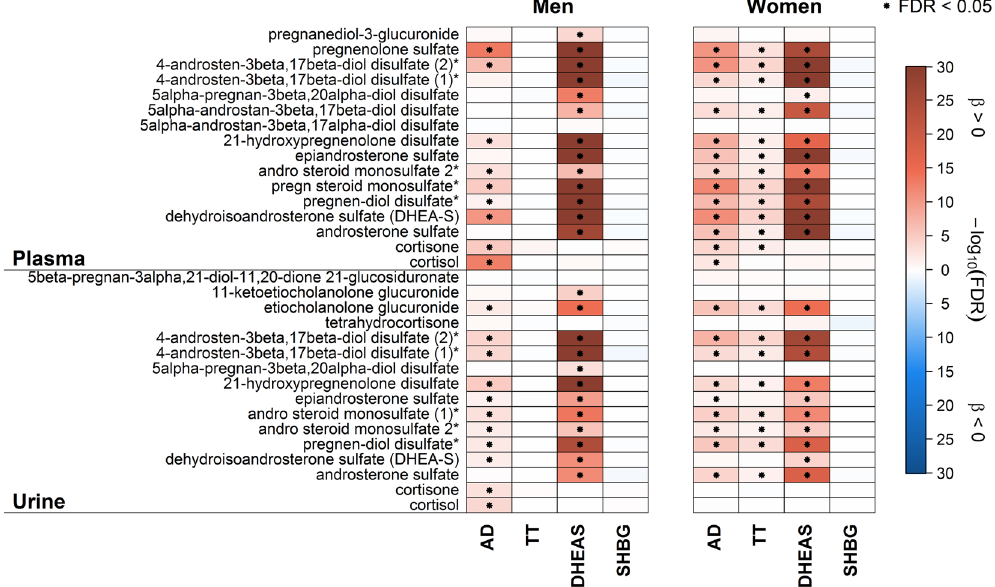
Figure 1. Heatmap of results from linear regression analyses with either androstenedione (AD), testosterone (TT), dehydroepiandrosterone sulfate (DHEAS) or sex hormone-binding globulin (SHBG) as exposure and steroid derivatives in plasma ( upper part ) or urine ( lower part ) as outcome in men ( left panel ) and women ( right panel ), respectively. Orange shading denotes positive and blue shading inverse associations. Dots indicate significant associations by controlling the false discovery rate (FDR) at 5%. Corresponding estimates and FDR values from linear regression analyses can be found in Tables S1–S4. * Metabolites were annotated based on fragmentation